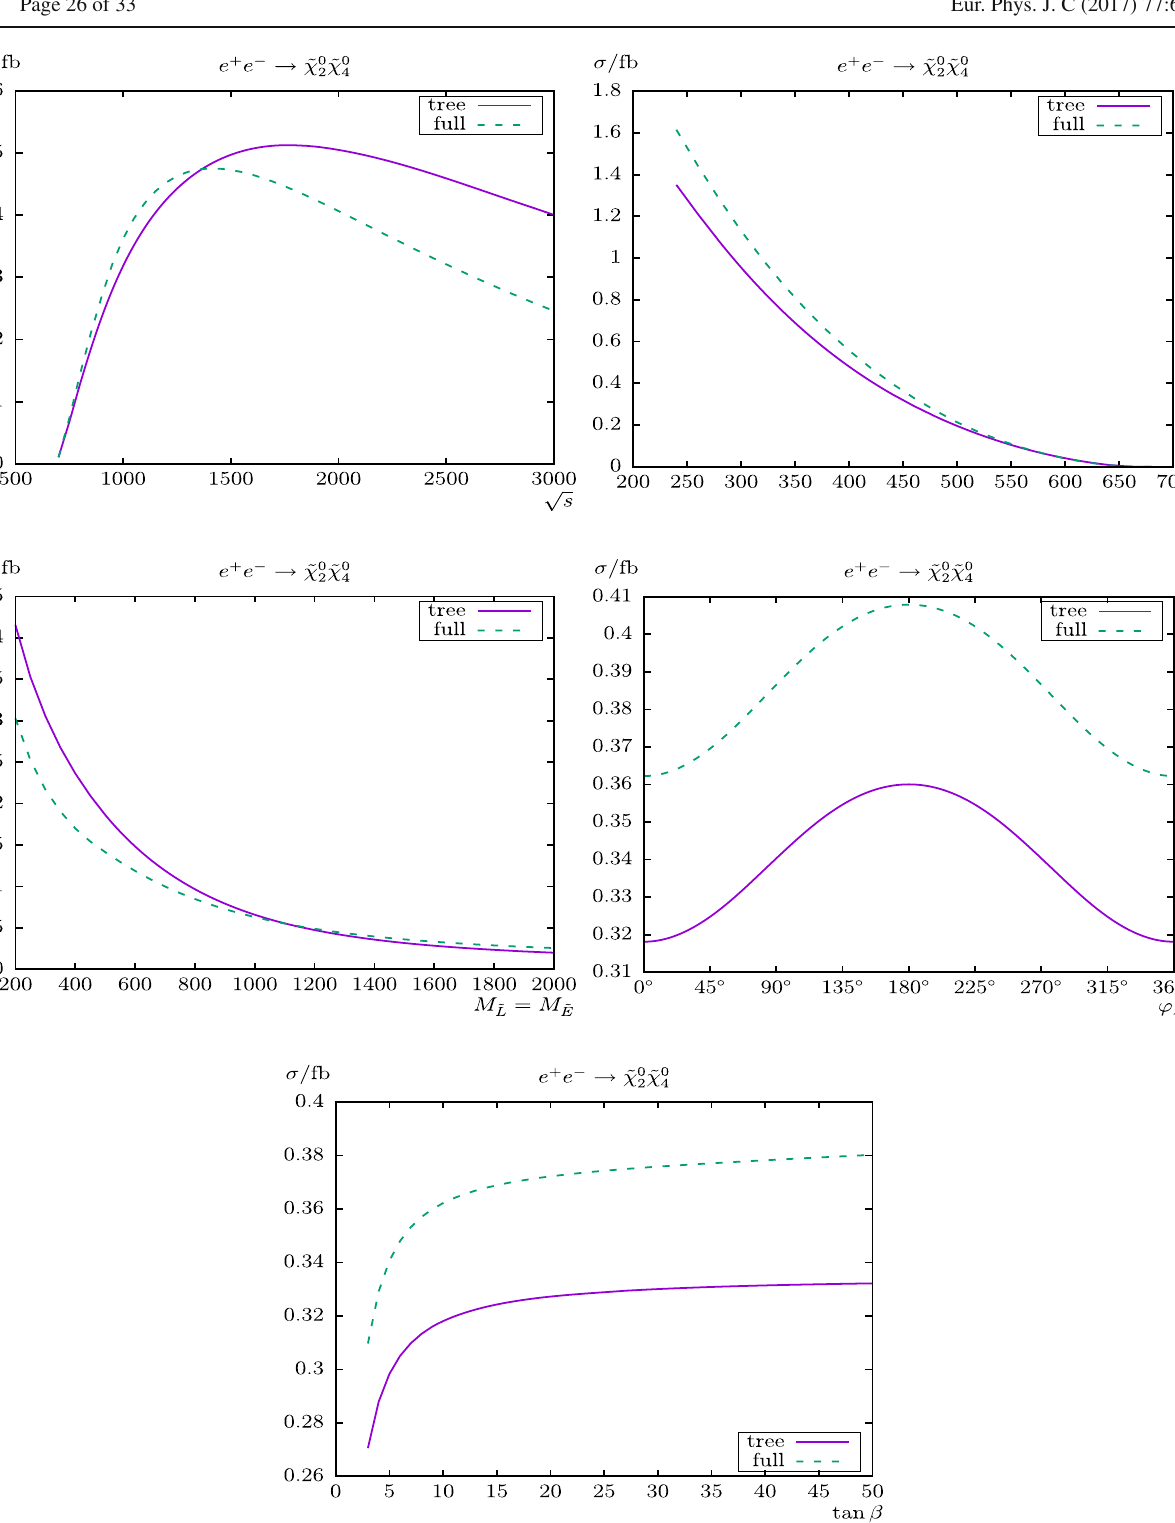
(right) varied; the middle plots show M ˜ varied, the lower plot shows the variation with t √ s (left) and μ